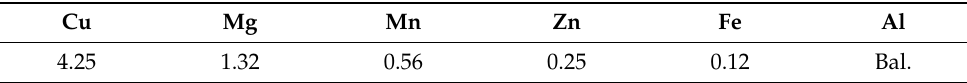
Table 1. Chemical composition of A2024-T3